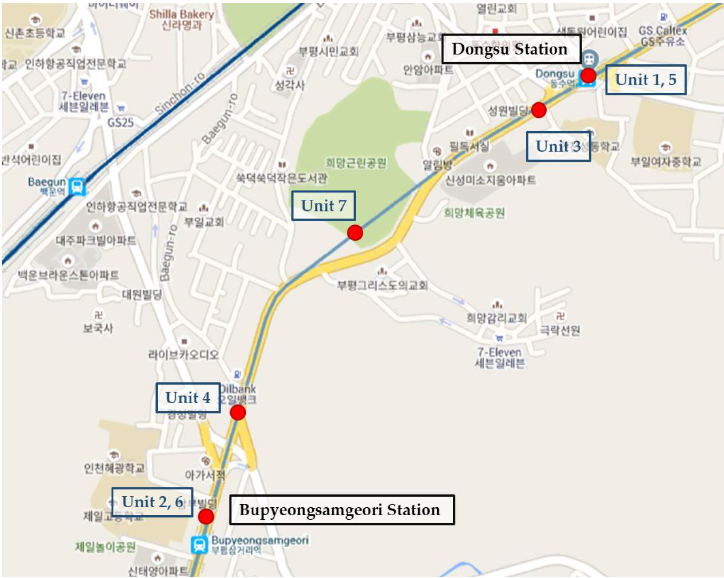
Figure 4. Monitoring locations in Incheon, Korea.